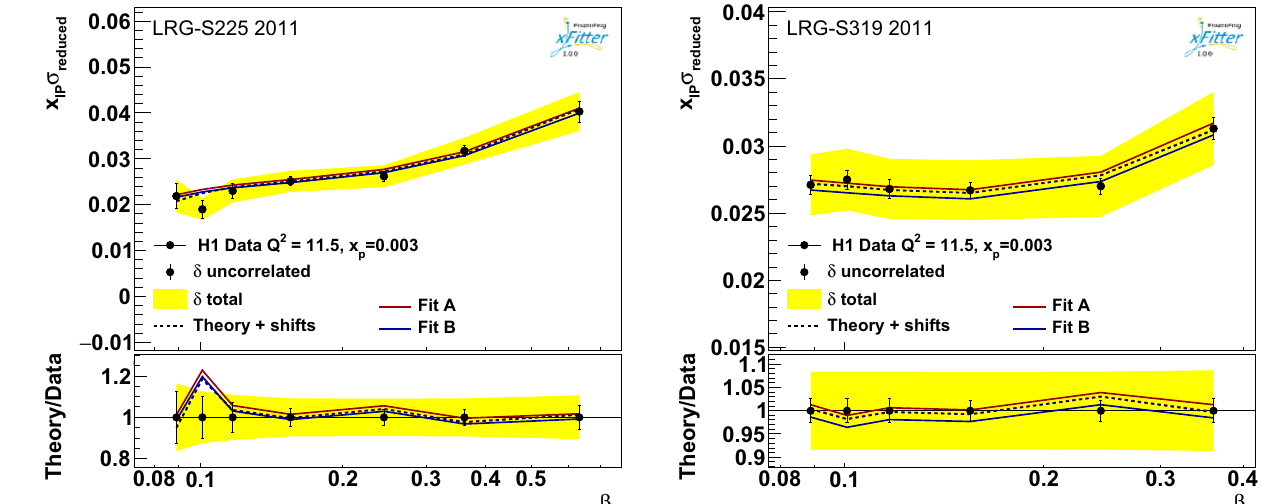
Fig. 14 The results of our NLO pQCD fit based on Fit A and Fit B for the reduced diffractive cross section x IP σ D ( 3 ) r as a function of β for x IP = 0 . 003 and Q 2 = 11 . 5 GeV 2 in comparison with H1-LRG-